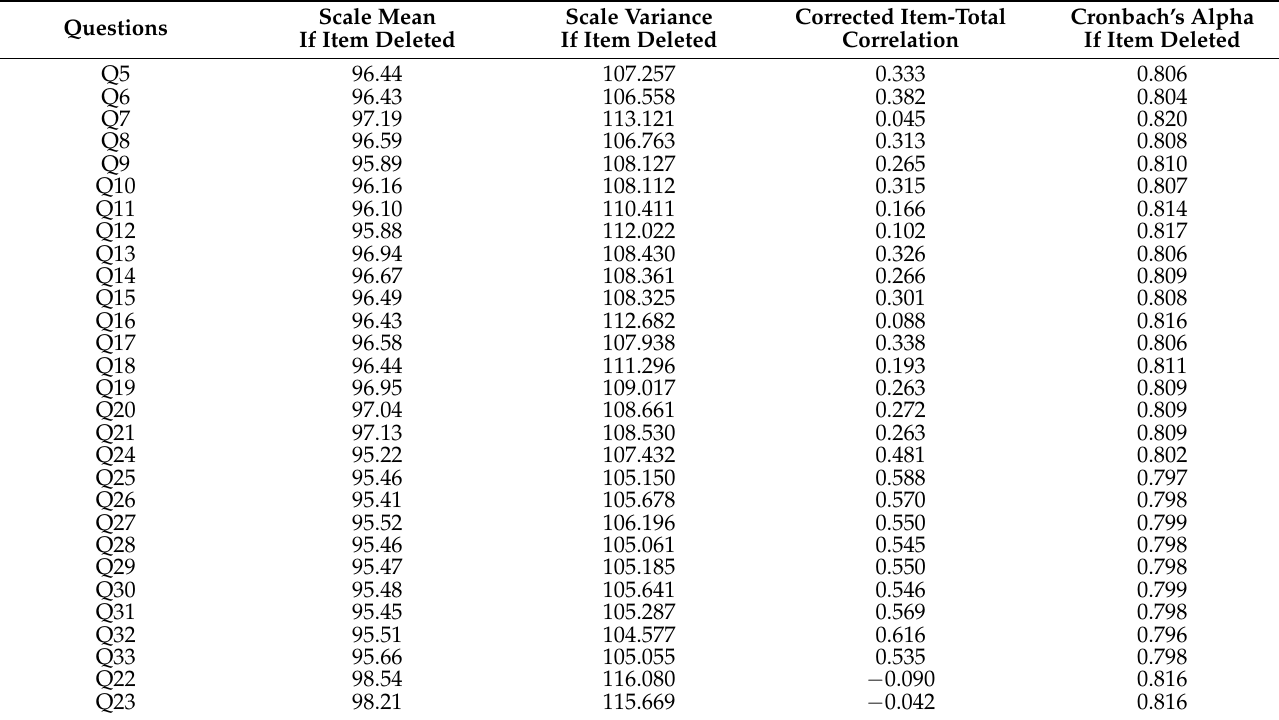
Table 7. Cronbach’s alpha—item total statistics.